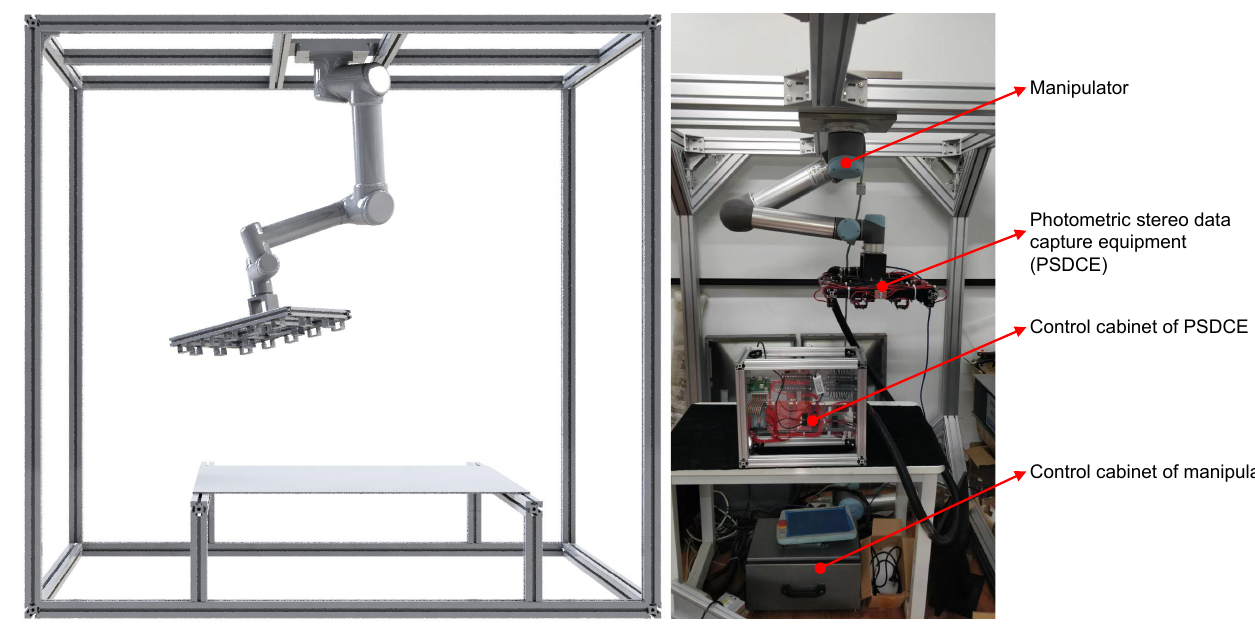
Figure 2. The diagram of our PSBDDS. The image on the left is a 3D model and the image on the right is a real device. The manipulator is mounted on a frame made of aluminium profiles and the PSDCE is attached to the end of the manipulator for capturing photometric stereo. The PSDCE and the manipulator are controlled by their corresponding control cabinets.